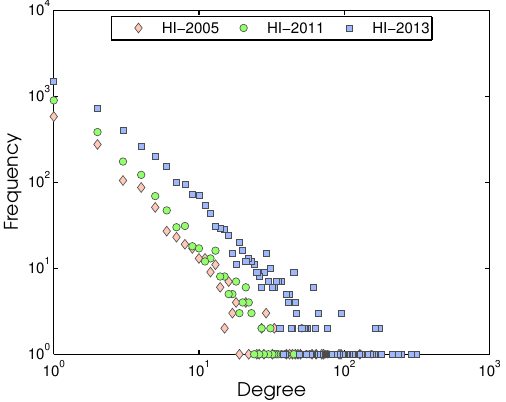
Figure 2: Degree distributions for HI-2005, HI-2011 and HI-2013 (log-log